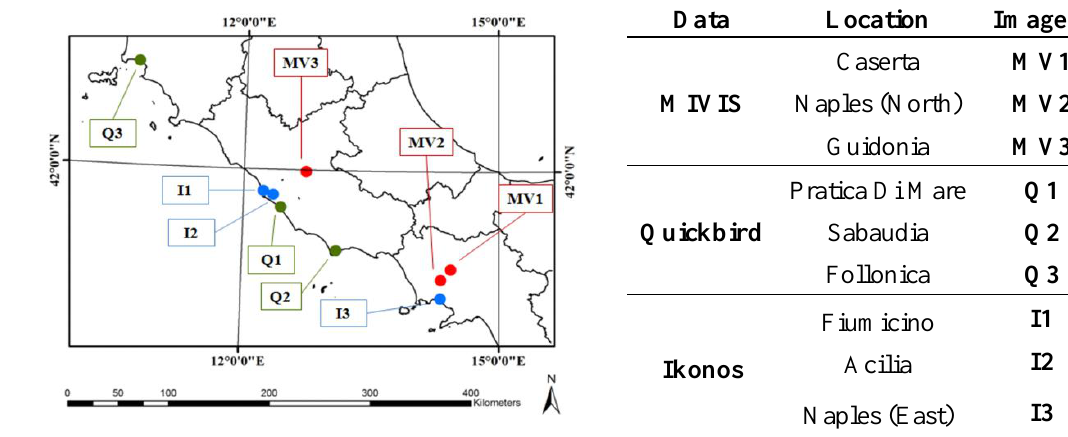
Table 1. Geographic location of study areas: Caserta (MV1), Napoli (North) (MV2) and Guidonia (MV3); Quickbird images of Pratica di Mare (Q1), Sabaudia (Q2) and Follonica (Q3) and, finally, Ikonos imagery of Fiumicino (I1), Acilia (I2) and Napoli (East) (I3) MIVIS, Multispectral Infrared and Visible Imaging